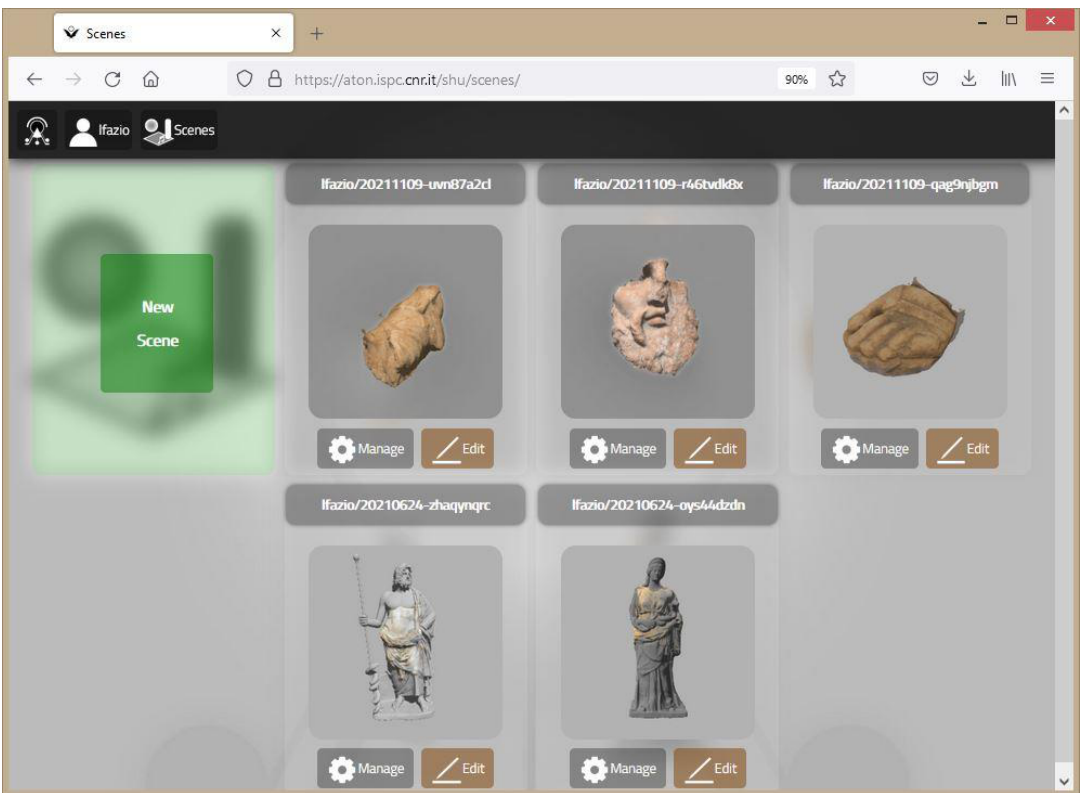
Figure 14. ATON front-end on standard browser for scenes gallery.